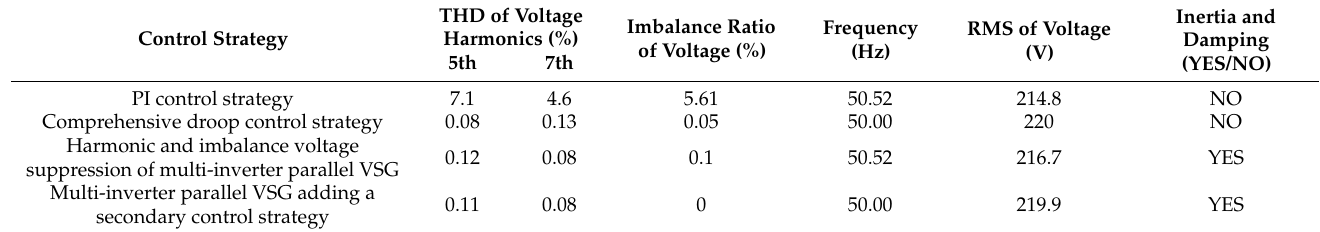
Table 2. Comparison of experimental